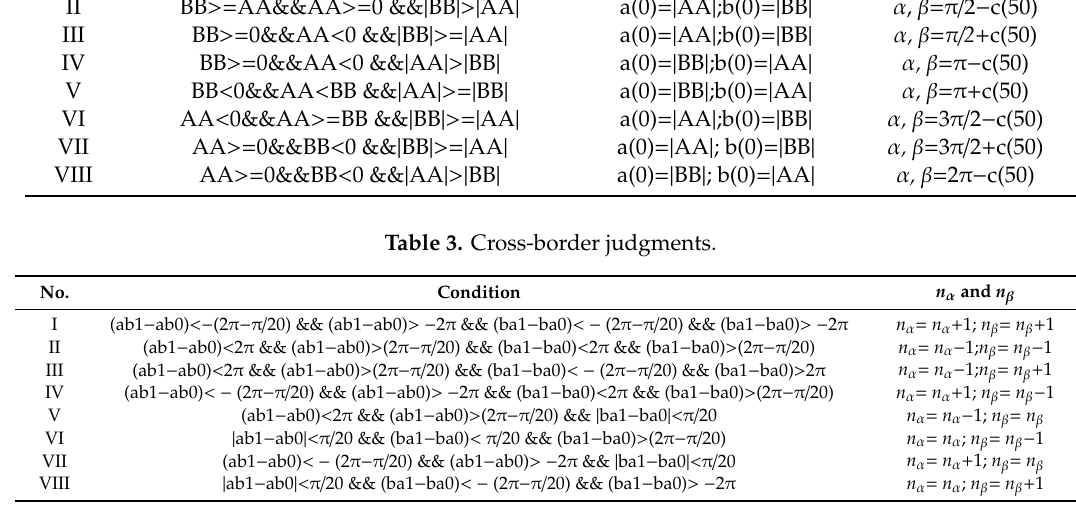
Table 3. Cross-border judgments.